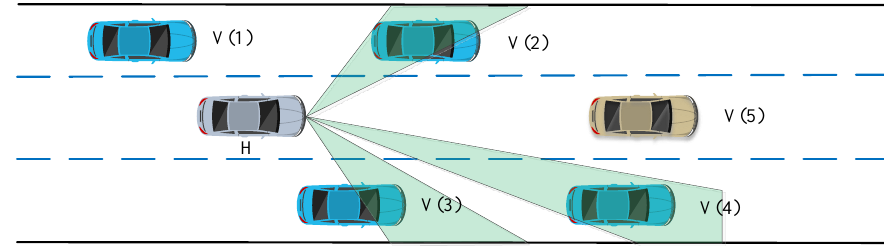
Figure 3. Identification of potential cut-in vehicles.